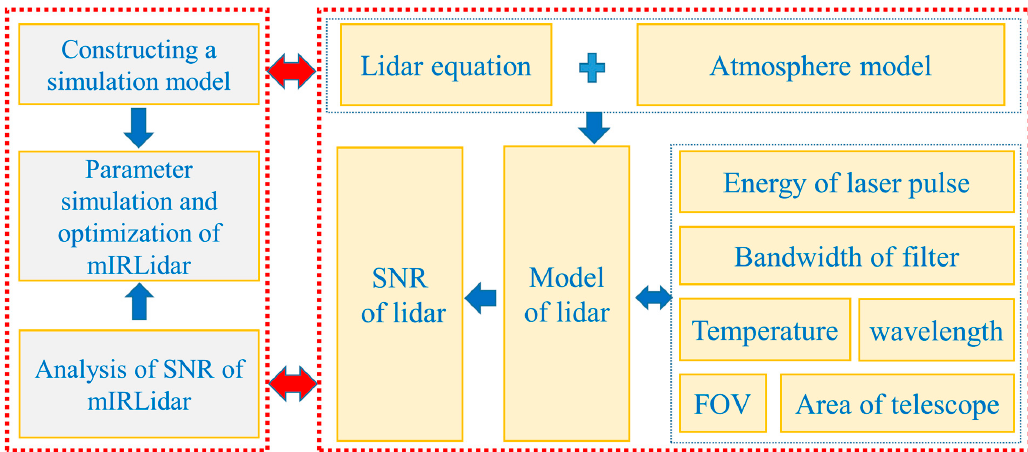
Figure 1. Model of parameter optimization.